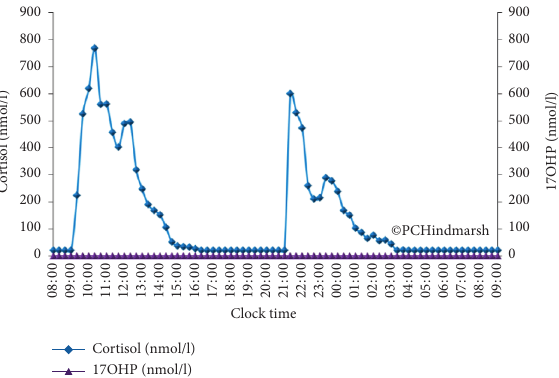
Figure 6: 24-hour plasma cortisol (blue line and diamonds) and 17 hydroxyprogesterone (purple line and triangles) concentration profiles from a 16-year-old postpubertal girl with salt-wasting congenital adrenal hyperplasia receiving hydrocortisone twice daily (10 mg at 09.00h and 7.5mg at 21.00 h) for the previous 3 years. The dosing was hydrocortisone dosing 10mg/m2/day and the 9-alpha fludrocortisone dose 100 micrograms per day. Blood samples are drawn at 20-minute intervals. Reproduced from Congenital Adrenal Hyperplasia: A Comprehensive Guide, Hindmarsh P and Geertsma K Elsevier, New York